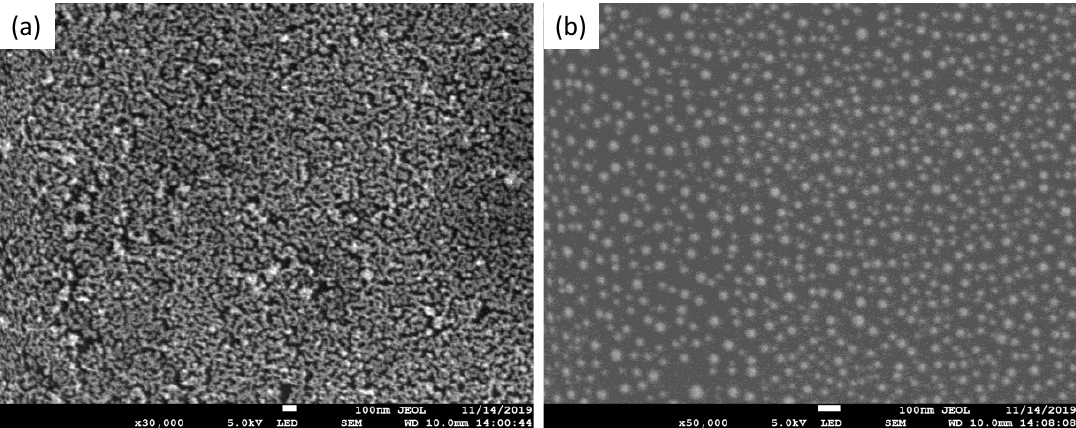
Figure 4. SEM images of AuNPs immobilized on optical fibers ( a ) before and ( b ) after the flame-brushing process.